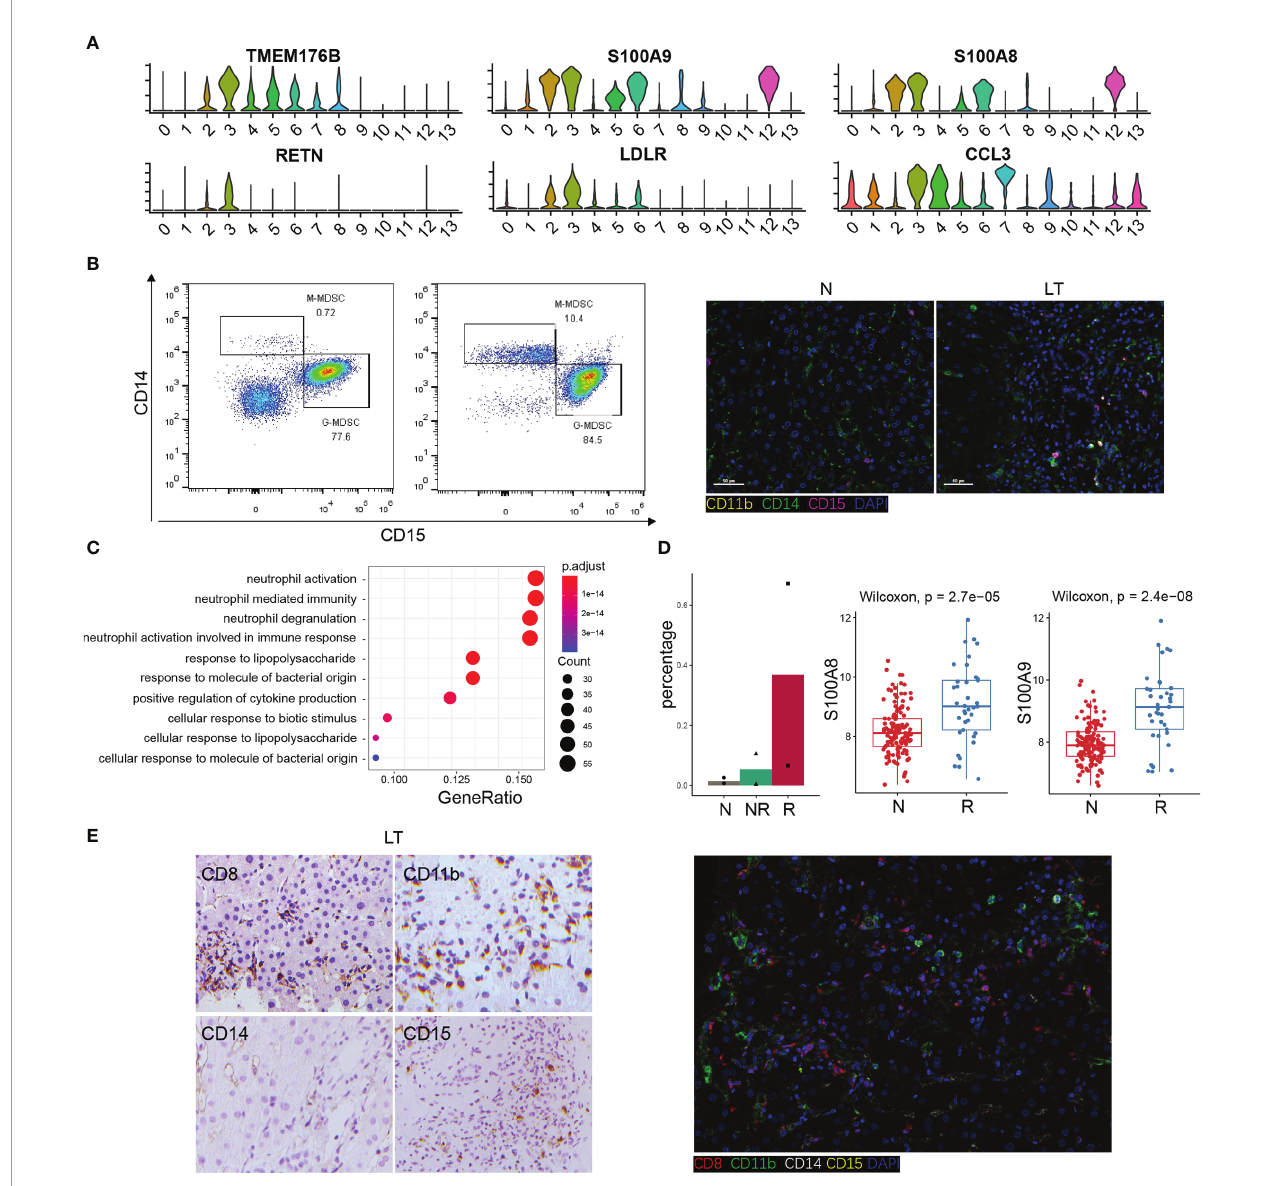
FIGURE 6 | The speci fi c phenotypes of LDLR+ MDSC. (A) Expression of differentially expressed genes in LDLR+ MDSC. (B) Flow cytometry analysis of MDSC fraction in normal and liver transplantation PBMC, and immuno fl uorescence including CD11b, CD14, and CD15 in normal and liver transplantation. (C) Enrichment analysis of Gene Ontology (GO) terms for differentially expressed genes in LDLR+ MDSC. (D) Fractions of LDLR+ MDSC in normal (n=3), stable (n=2), and rejection samples (n=2) after liver transplantation. Bulk RNA-seq expression of S100A8 and S100A9 in stable (n=129) and rejection samples (n=37) after liver transplantation. (E) Immunohistology of CD8, CD11b, CD14, and CD15 in liver transplantation tissue, and immuno fl uorescence including CD8, CD11b, CD14, and CD15 in liver